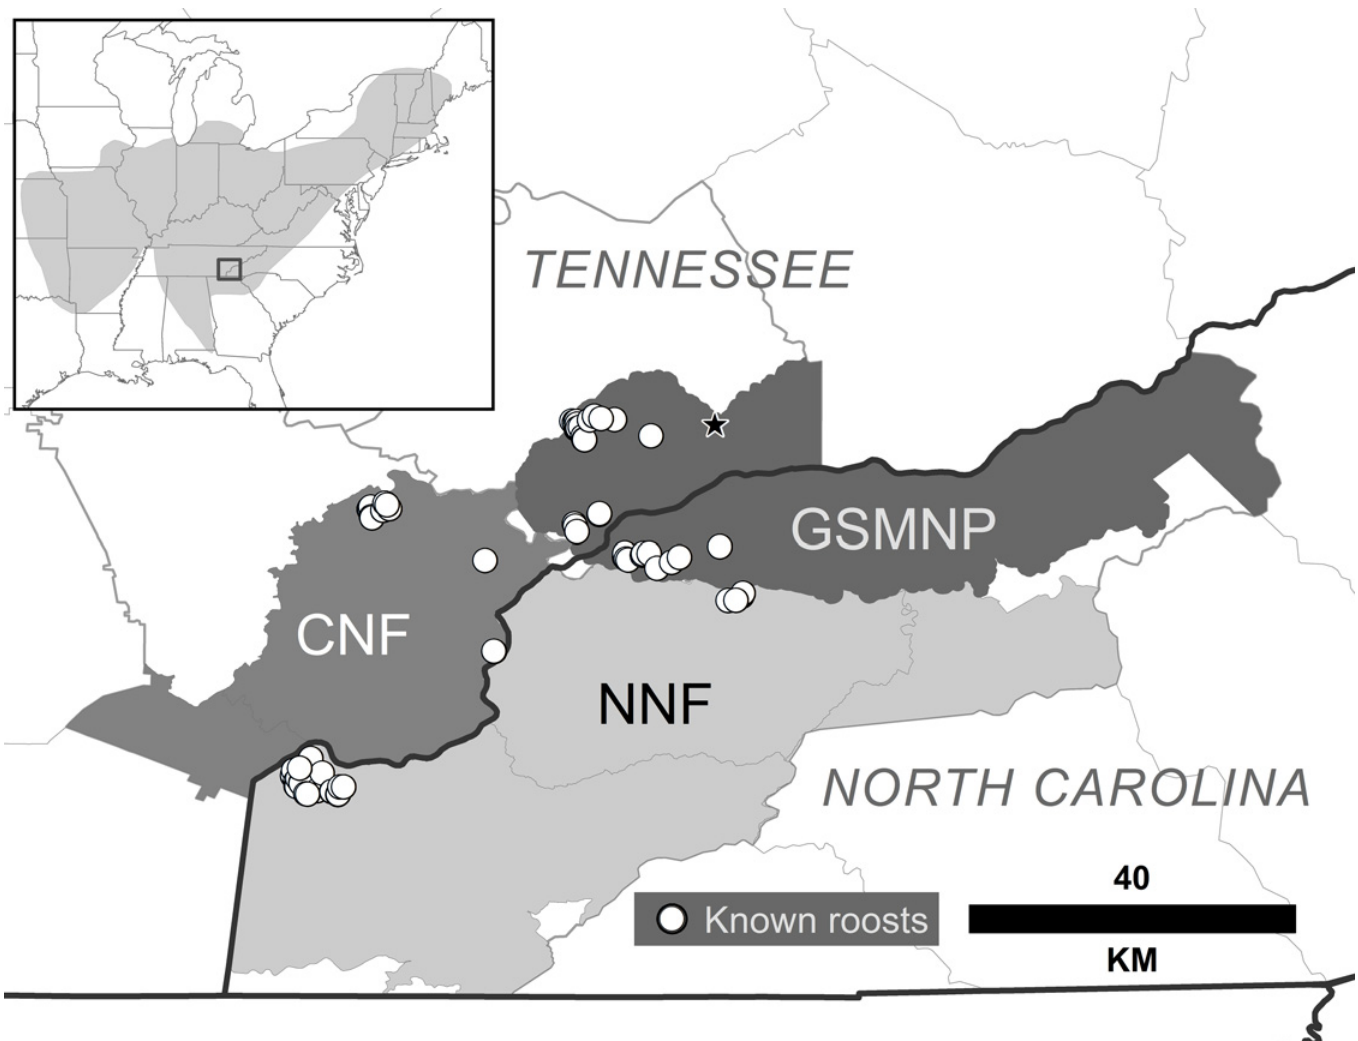
Fig 1. Locations of 76 roosts used by Myotis sodalis . Roosts for adult female and juvenile Myotis sodalis (May to August, 2008 – 2012) in the study area in the southern Appalachian Mountains (inset is M . sodalis distribution in eastern North America). A series of caves (star) are thought to be used as hibernation sites by M . sodalis that form summer colonies in this region. The study area (~281,800 hectares) included portions of the Great Smoky Mountains National Park (GSMNP), Nantahala National Forest (NNF), and Cherokee National Forest